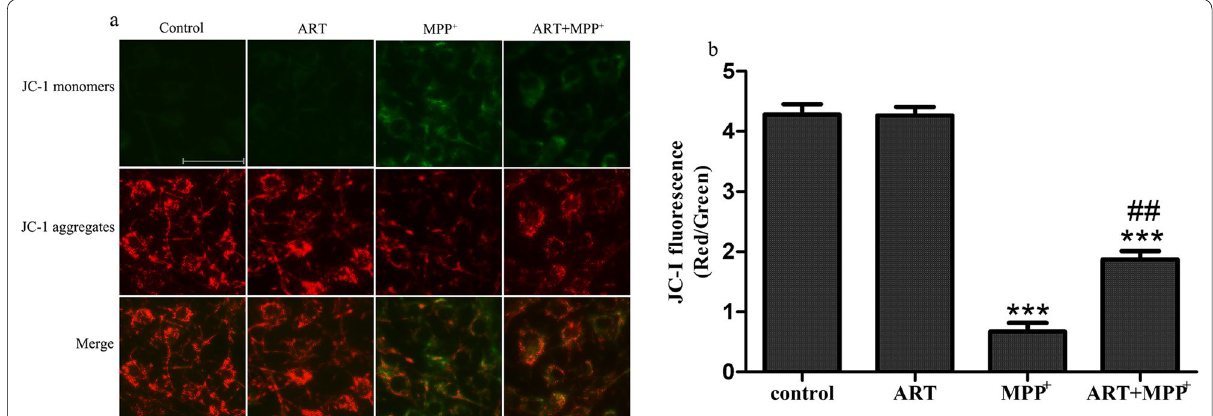
Fig. 3 ART alleviated the MPP + -induced mitochondrial damage. In the JC-1 staining data, red fluorescence represents JC-1 aggregates and indicates that the MMP is normal, and green fluorescence represents JC-1 monomers and indicates that the MMP is decreased ( a ). The ratio of red fluorescence intensity to green fluorescence intensity was analyzed by ImageJ ( b ). The results are presented as the mean bar